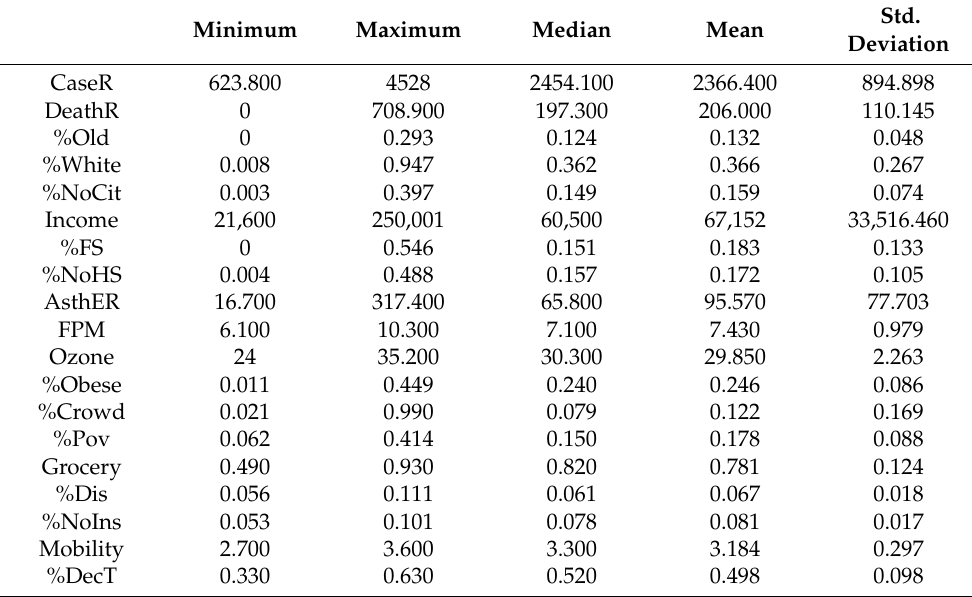
Table 3. Numerical characteristics of New York City for all quantitative